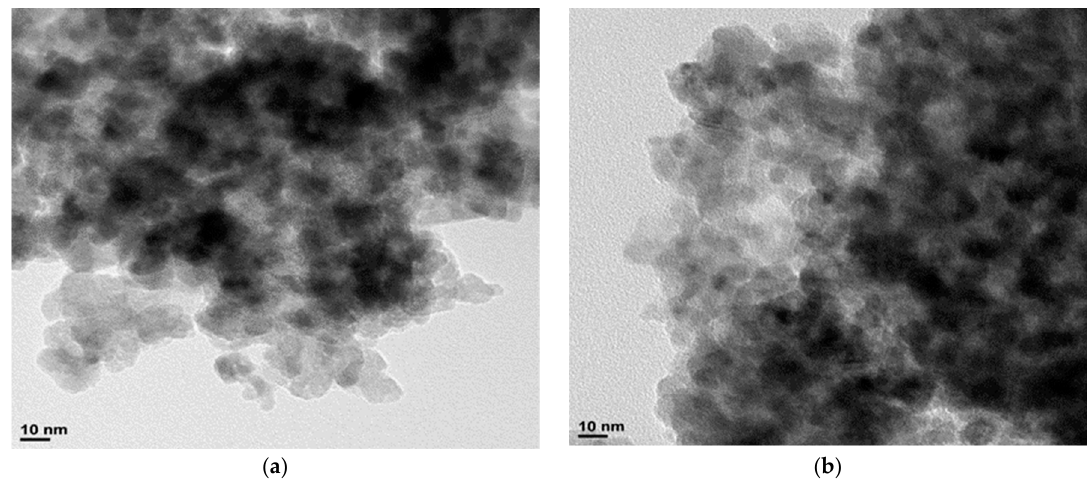
Figure 2. Transmission electron microscopy ( TEM) images of ( a ) Co 3 O 4 and ( b ) CuCo 2 O 4